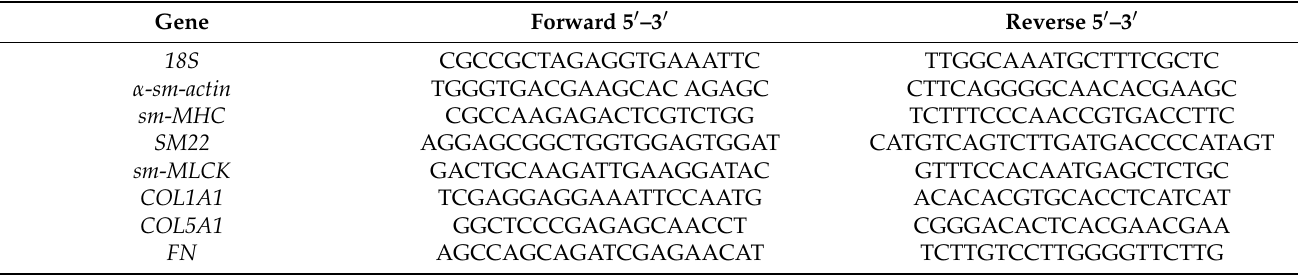
Figure 4. Wound healing assay. ( A )—ASMC migration after 0 h, 24 h, 48 h, 72 h incubation with eosinophils; ( B )—PF migration after 0 h, 24 h, 48 h, 72 h incubation with eosinophils. AA n = 5, SNEA n = 5, HS n = 5. Presented as a cell-covered area, as a percentage of control cells. AA—allergic asthma; ASMC—airway smooth muscle cells; HS—healthy subject; PF—pulmonary fibroblast; SNEA—severe non-allergic eosinophilic asthma patients. Data presented as mean ± SEM. Table 2. Primers used for gene expression